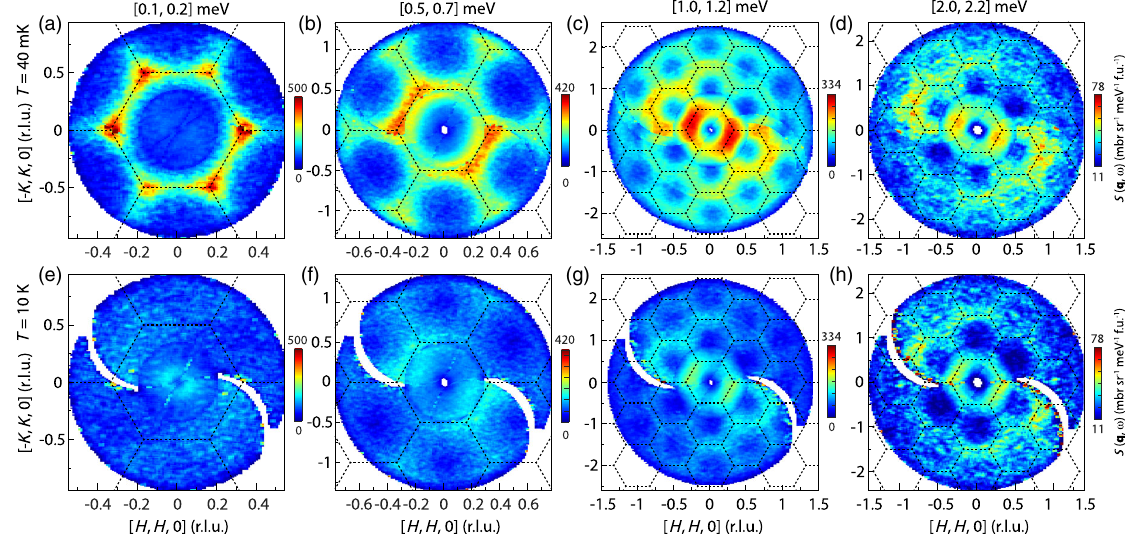
FIG. 3. Constant-energy images of spin excitations in the ½ H; K; 0 (cid:3) plane. (a) – (d) Images at T ¼ 40 mK and (e) – (h) 10 K. The intensity along the vertical ½ 0 ; 0 ; L (cid:3) direction is integrated. Spin excitations for (a),(e) E ¼ 0 . 15 (cid:2) 0 . 05 , (b),(f) 0 . 6 (cid:2) 0 . 1 , (c),(g) 1 . 1 (cid:2) 0 . 1 , and (d),(h) 2 . 1 (cid:2) 0 . 1 meV are measured with E ¼ 1 . 77 , 3.70, 12.14, and 12.14 meV, respectively. The black dashed lines i mark the Brillouin zones in the reciprocal space. The data are collected in 180° range of sample rotation around the c axis. The 360° circular coverage is generated by averaging the raw data and its mirror in the ½ H; K; 0 (cid:3) plane. The C 2 -like anisotropy has been attributed to a trivial effect caused by sample-volume change in beam during sample rotation for neutron scattering measurements in ½ H; K; 0 (cid:3) plane [38].